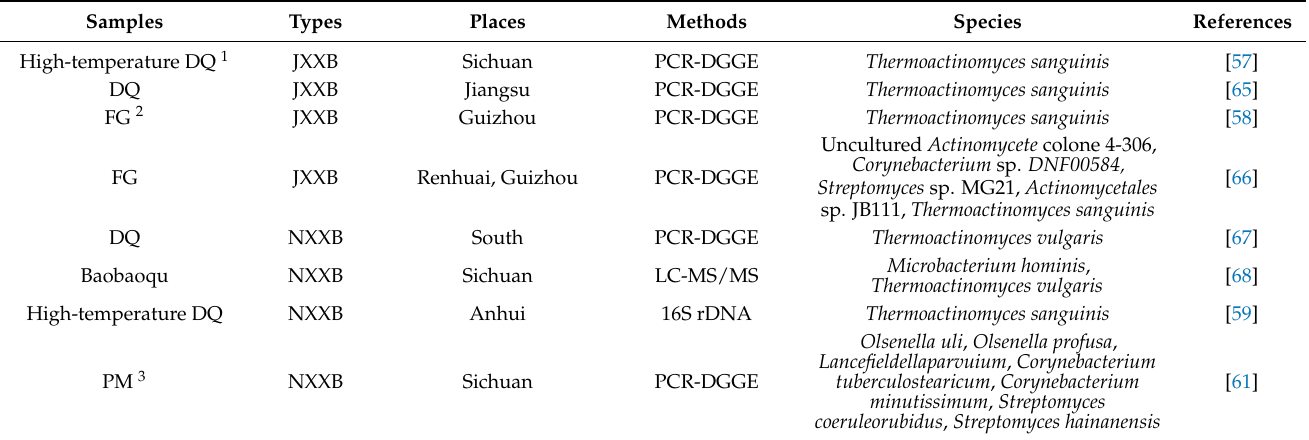
Table 2. Actinomycete species identified by culture-independent